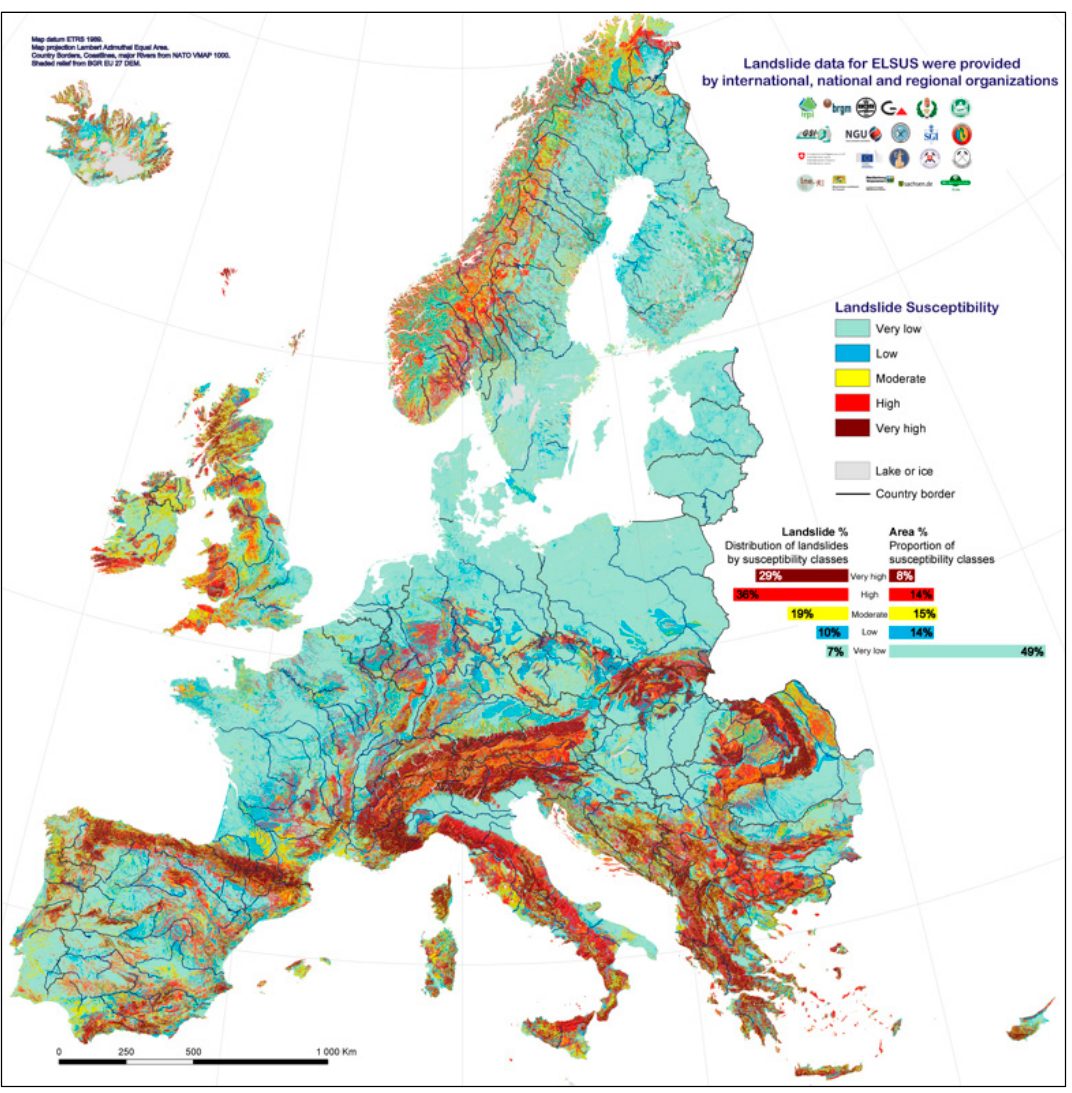
Figure 1. Landslide susceptibility map of Europe [4].